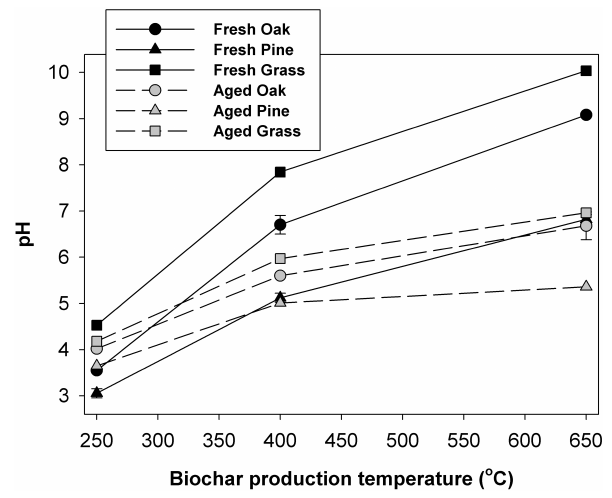
Figure 1. Relationship between pH and biochar production temper- ature for a range of fresh and aged biochars. Error bar shows the standard deviation of two replicate analyses.